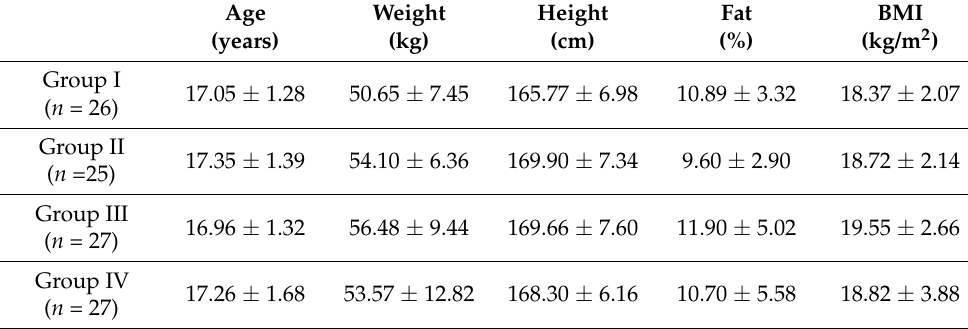
Table 3. Demographic characteristics and BMI of the study groups ( n =